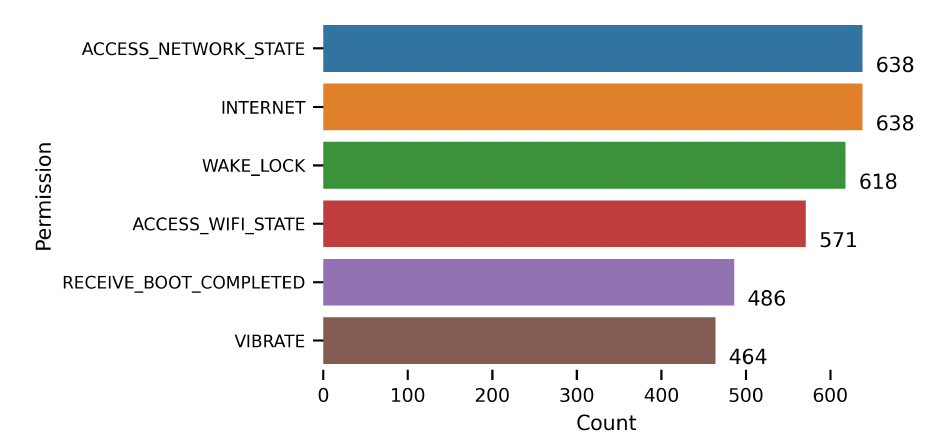
Figure 5. Wake Lock Permissions based on Google Play Store